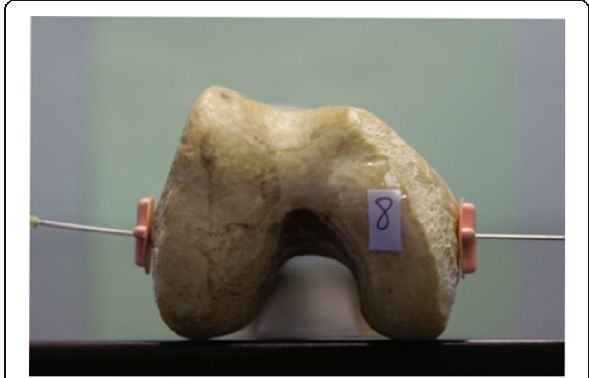
Fig. 1 Photographic image along femoral mechanical axis